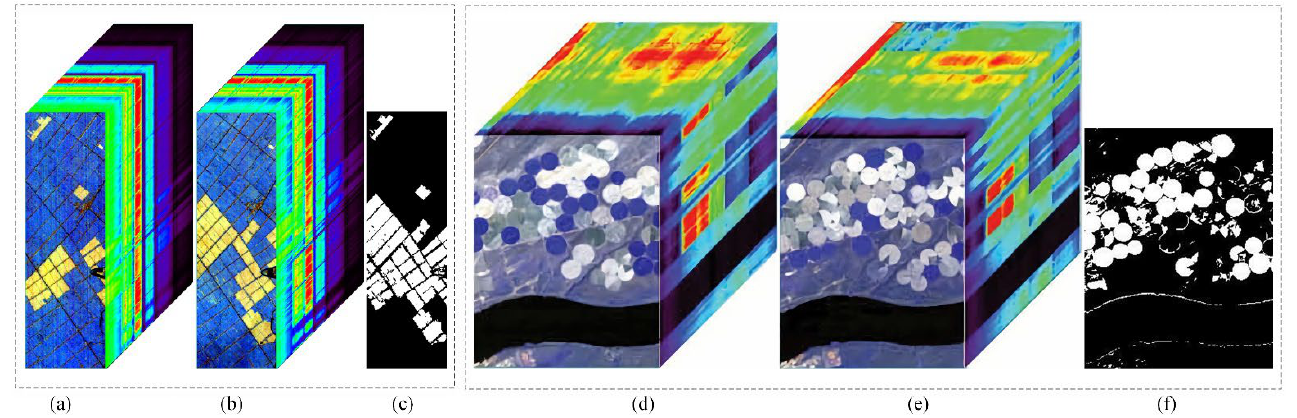
Figure 5. Experimental datasets. ( a ) China imagery on 3 May 2006. ( b ) China imagery on 23 April 2007. ( c ) Ground-truth change map of the China dataset. ( d ) USA imagery on 1 May 2004. ( e ) USA imagery on 8 May 2007. ( f ) Ground-truth change map of the USA dataset.